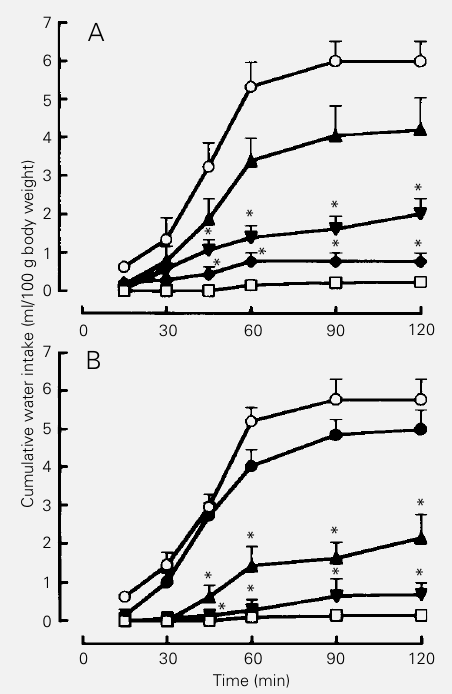
Figure 1 - Effect of PbAc and CdCl 2 on water intake induced by third ventricle ISO injections. Data are reported as cumulative water intake (ml/100 g body weight). Panel A , Water intake in animals receiving NaAc (300 pmol/rat) + saline ( l ); NaAc (300 pmol/rat) + ISO (160 nmol/rat) ( ! ); PbAc (3 pmol/rat) + ISO (160 nmol/rat) ( £ ); PbAc (30 pmol/rat) + ISO (160 nmol/rat) ( t ); PbAc (300 pmol/rat) + ISO (160 nmol/ rat) ( ¢ ). Data are reported as mean – SEM for 12 animals in each group. *P<0.01 compared to the respective NaAc + ISO controls (repeated measures ANOVA followed by the ScheffØ test). Panel B , Water intake in animals receiving saline + saline ( l ); saline + ISO (160 nmol/rat) ( ! ); CdCl 2 (0.3 pmol/rat) + ISO (160 nmol/rat) ( • ); CdCl 2 (3.0 pmol/rat) + ISO (160 nmol/rat) ( £ ); CdCl 2 (30.0 pmol/rat) + ISO (160 nmol/rat) ( t ). Data are re- ported as mean – SEM for 12 animals in each group. *P<0.01 compared to the respective sa- line + ISO controls (repeated measures ANOVA followed by the ScheffØ